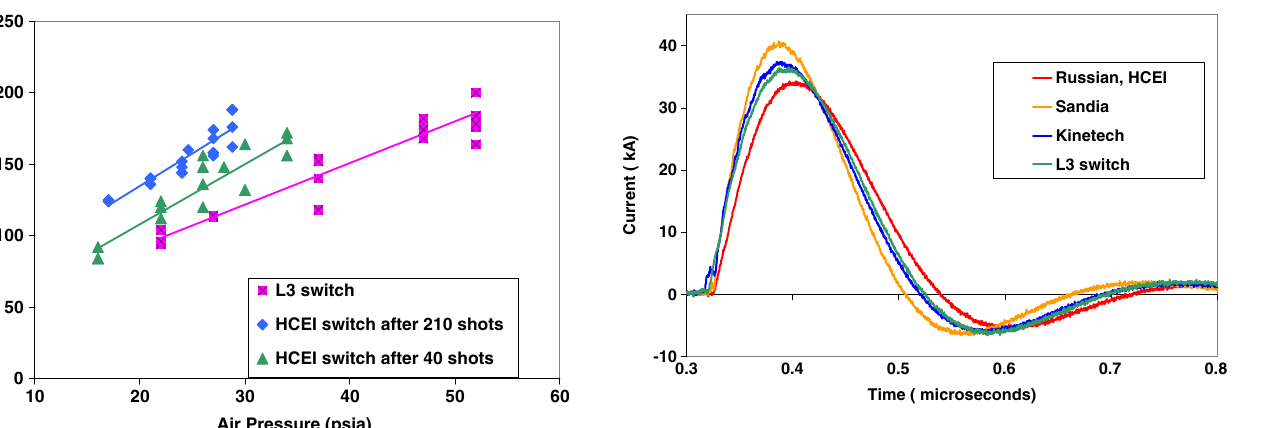
FIG. 13. (Color) Current traces with four different switches in our brick. The 40 nF capacitors were charged to (cid:2) 100 kV and discharged into a matched